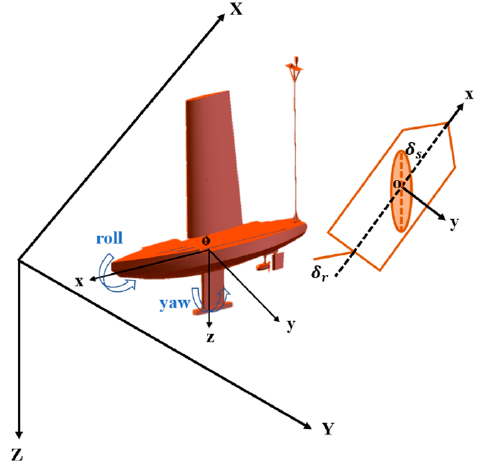
Figure 1. Coordinate system of the unmanned sailboat.